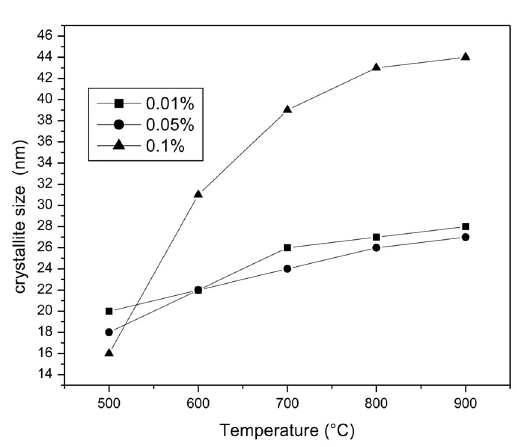
Figure 2: Effect of the calcinations temperature on the crystallite size of the spinel phase.